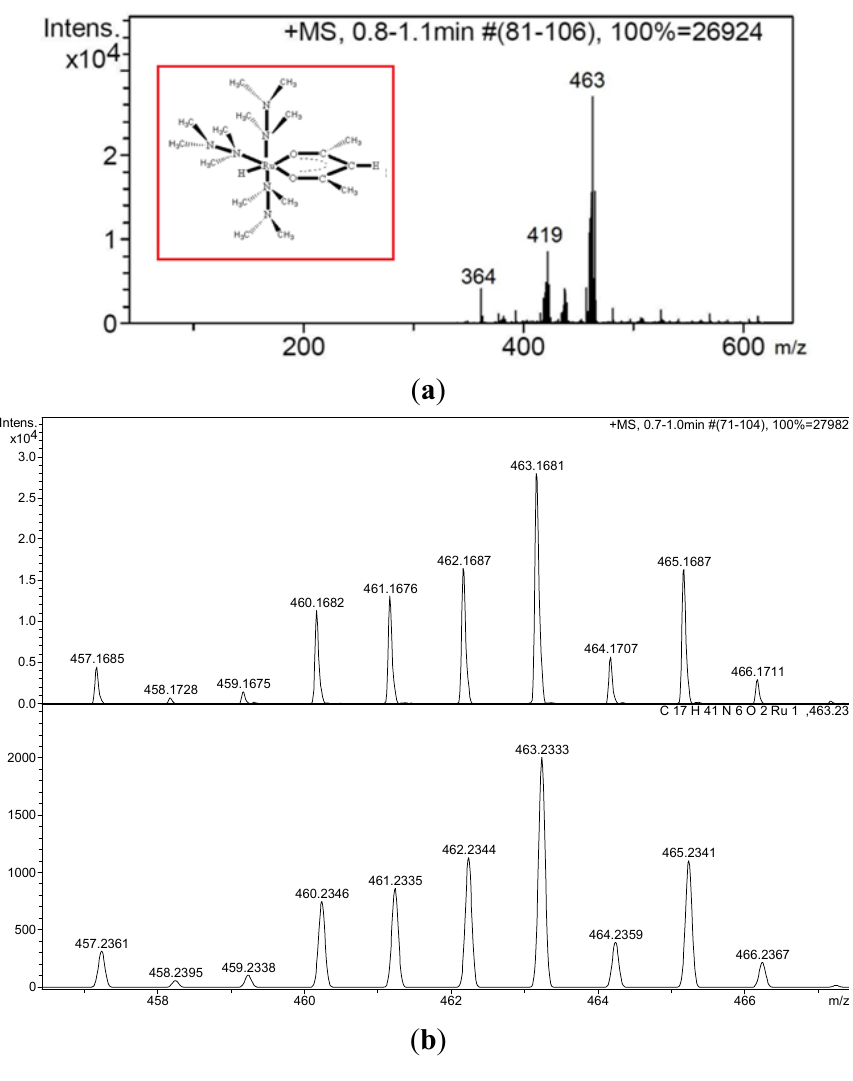
Figure 7. ( a ) Mass spectrum of the ruthenium(II) species, [Ru(N 2 Me 4 ) 3 (acac)H], isolated after catalytic dehydrogenation of dimethylamine borane starting with Ru(acac) 3 . ( b ) High resolution mass spectrum of [Ru(N 2 Me 4 ) 3 (acac)H] and the isotope distribution simulated for C 17 H 41 N 6 O 2